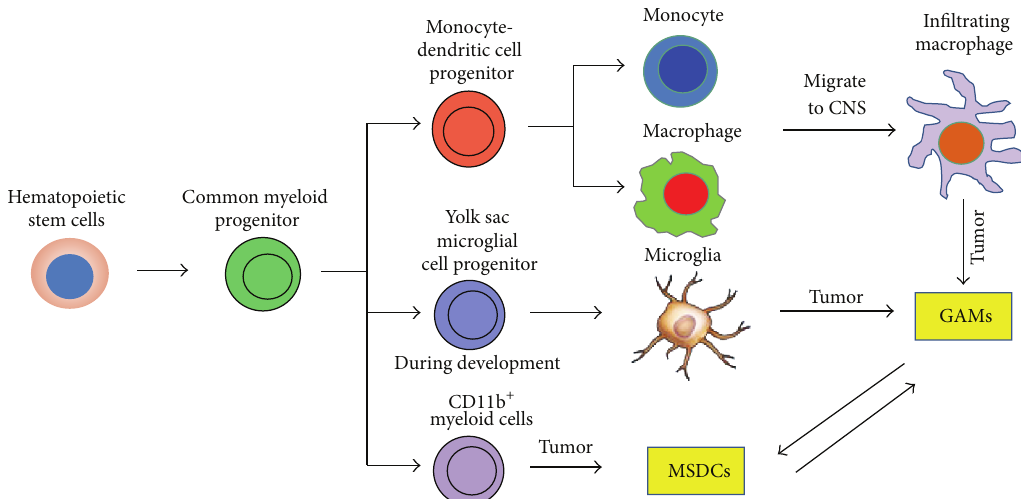
Figure 1: Cell lineage derivation of the CNS microglia/macrophage is depicted, with arrows indicating lineage relatedness. Myeloid-derived suppressor cells (MDSCs) are a lineage term describing glioma-associated microglia/macrophages